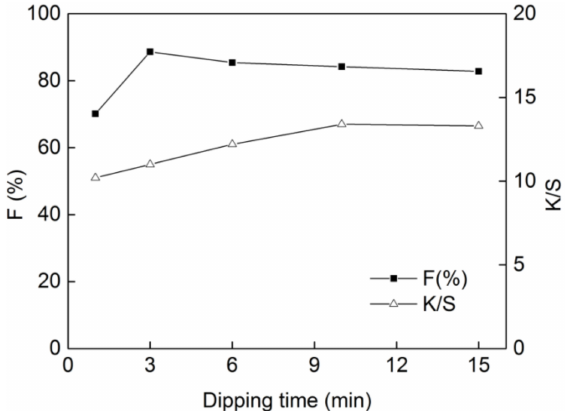
Figure 6. Effect of dipping time on dyeing properties of DB 1 (dye concentration of 25 g/L, sodium carbonate of 12 g/L and steaming time of 15 min with “one-dip–one-nip”